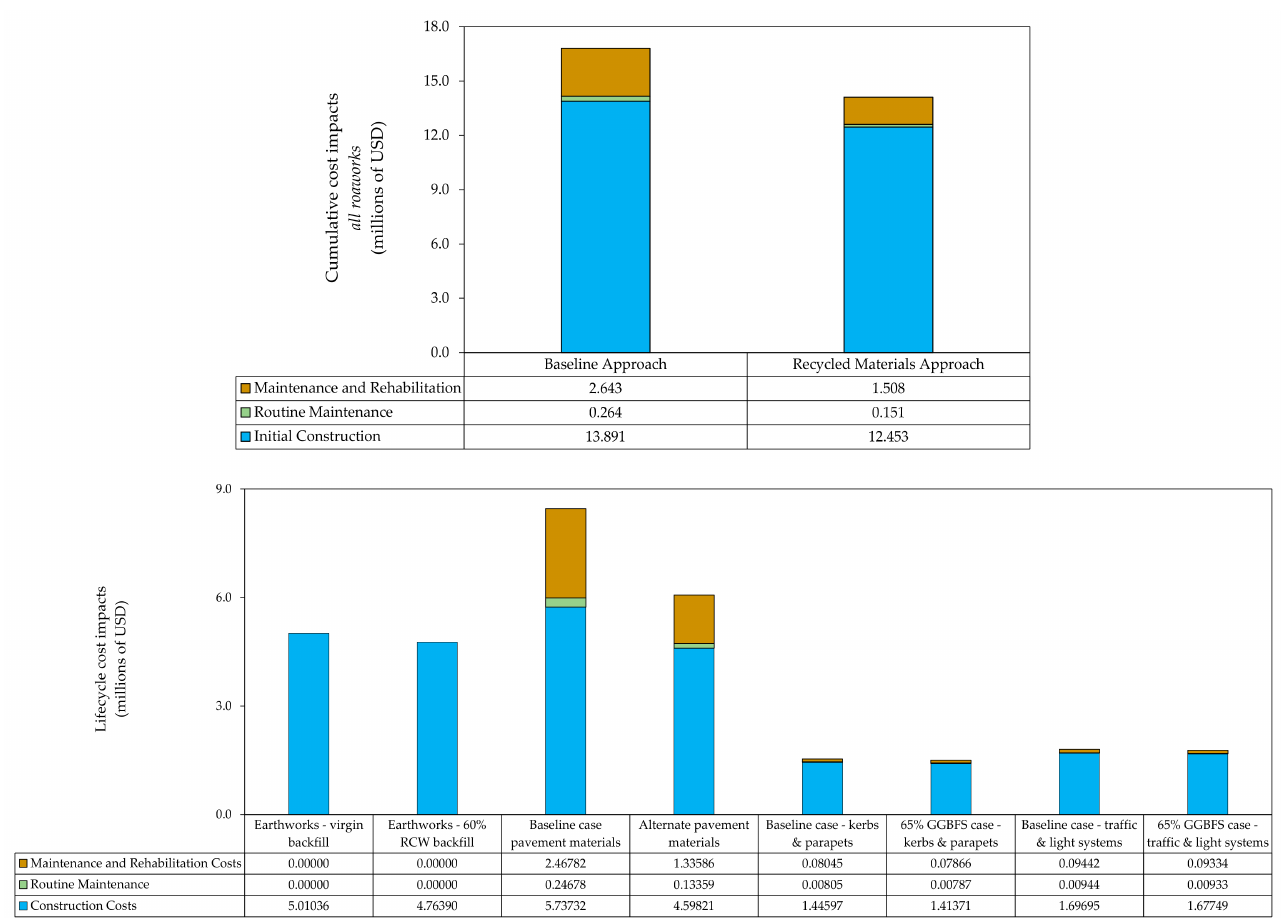
Figure 5. Cost impacts and reduction potential distribution across all lifecycle stages for complete